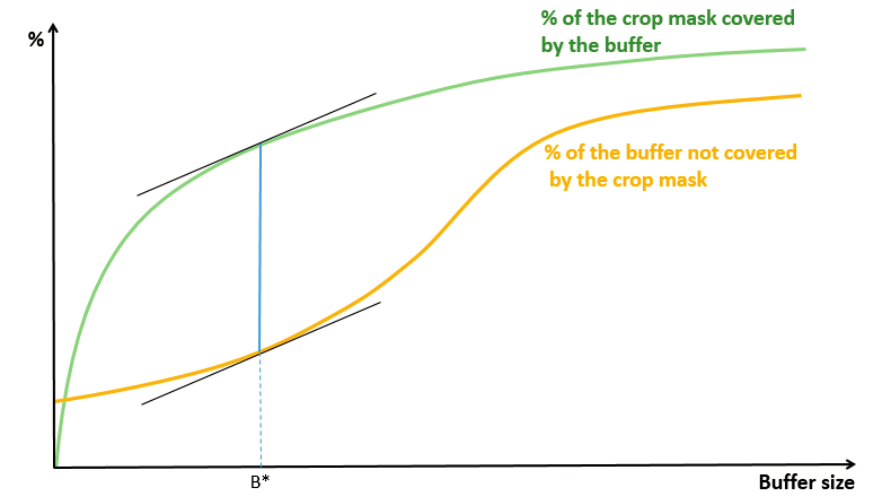
Figure 1. Stylized representation of the expected relationship between the buffer size around villages and (i) the surface of the crop mask covered by the resulting village buffer mask (green line) and (ii) the surface of the VBM not covered by the crop mask (orange line). The optimal buffer size maximizes the difference between the two curves and is represented by the point B *